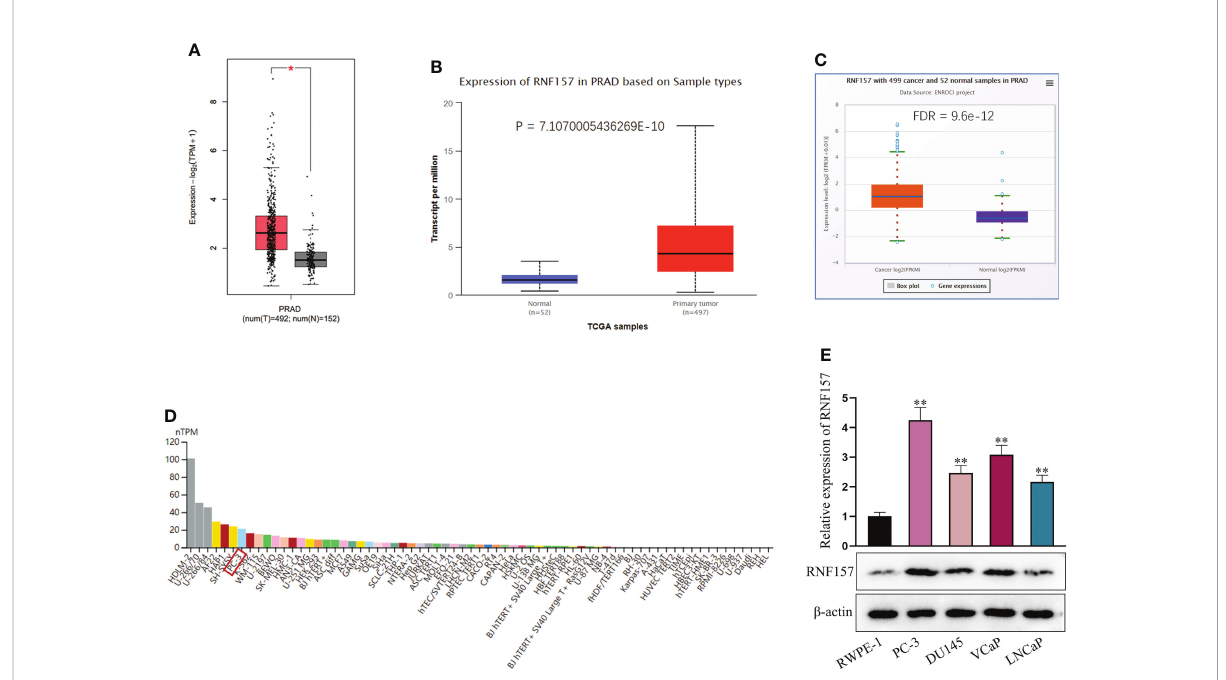
FIGURE 1 RNF157 was overexpressed in PCa. (A – C) GEPIA, UALCAN and ENCORI were applied to search for expression of RNF157 in PRAD tissues. (D) RNF157 expression in different cell lines, including PCa cell line (PC-3), was predicted on THE HUMAN PROTEIN ATLAS. (E) RNF157 expression in different PCa cell lines and in RWPE-1 cell line was analyzed via RT-qPCR and western blot. *P < 0.05, **P < 0.01.